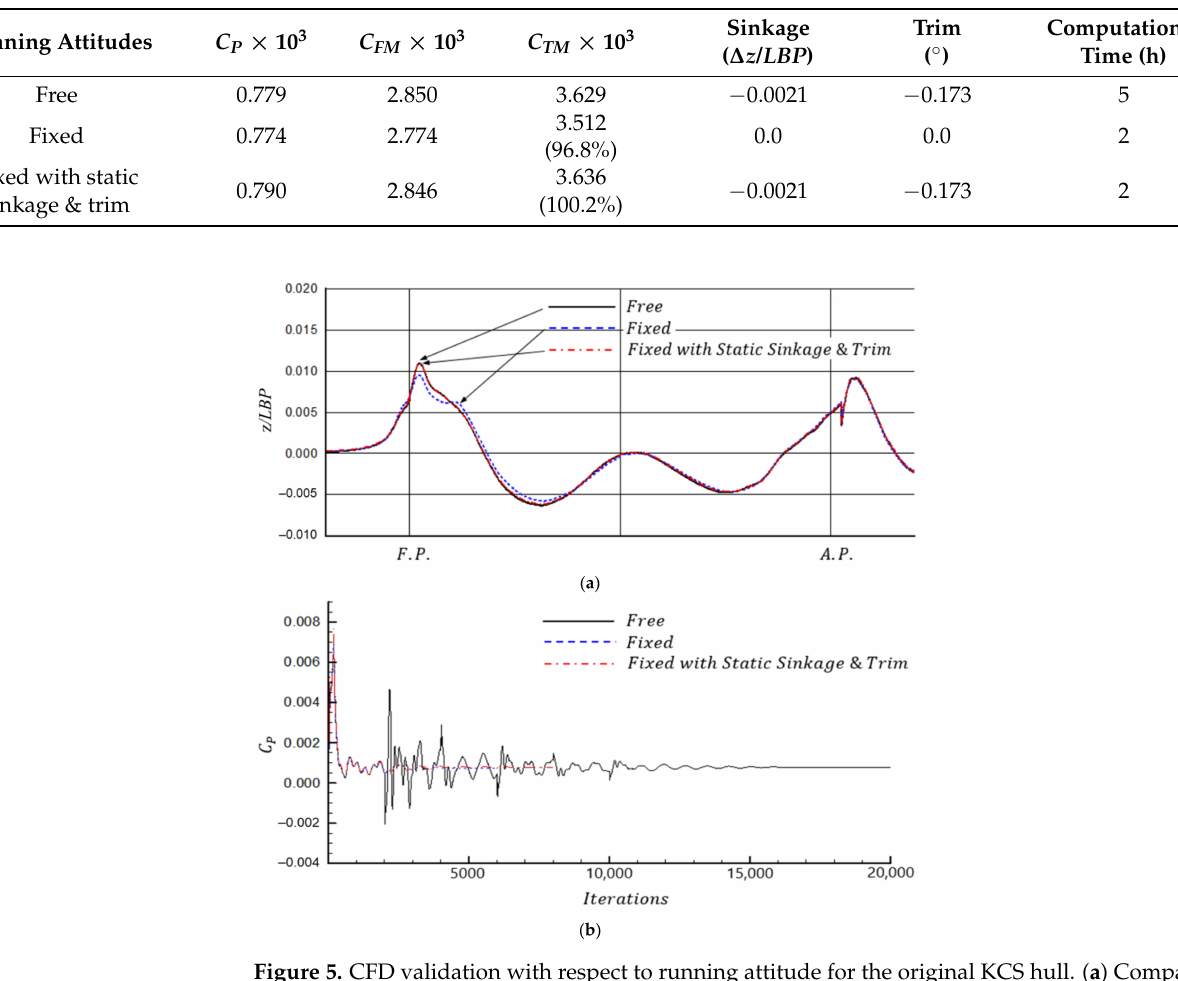
Figure 5. CFD validation with respect to running attitude for the original KCS hull. ( a ) Comparison of wave profile; ( b ) Comparison of convergence